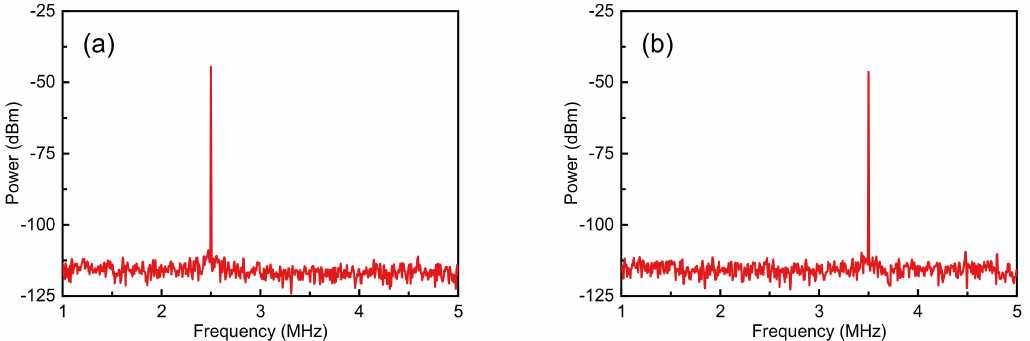
Figure 3. Measured system output electrical spectrum for ( a ) a +0.5 MHz DFS and ( b ) a − 0.5 MHz DFS.